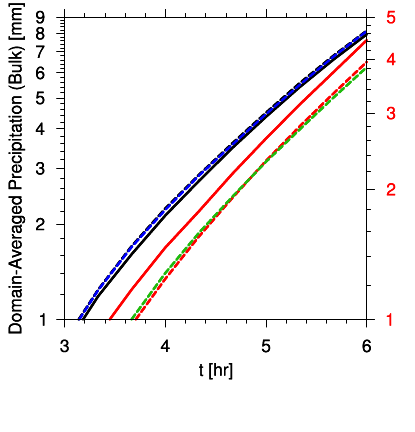
Fig. 15. Domain-averaged cumulative precipitation for the highRH simulations using (a) bulk and (b) bin microphysics. CCN/IN ef- fects are shown for the “Clean” (solid), “Semi-Polluted” (dashed), and “IN-Polluted” (dotted) scenarios. Note the difference in the y - axis scale between (a) and (b) . The bulk and bin results have been separated here for clarity.